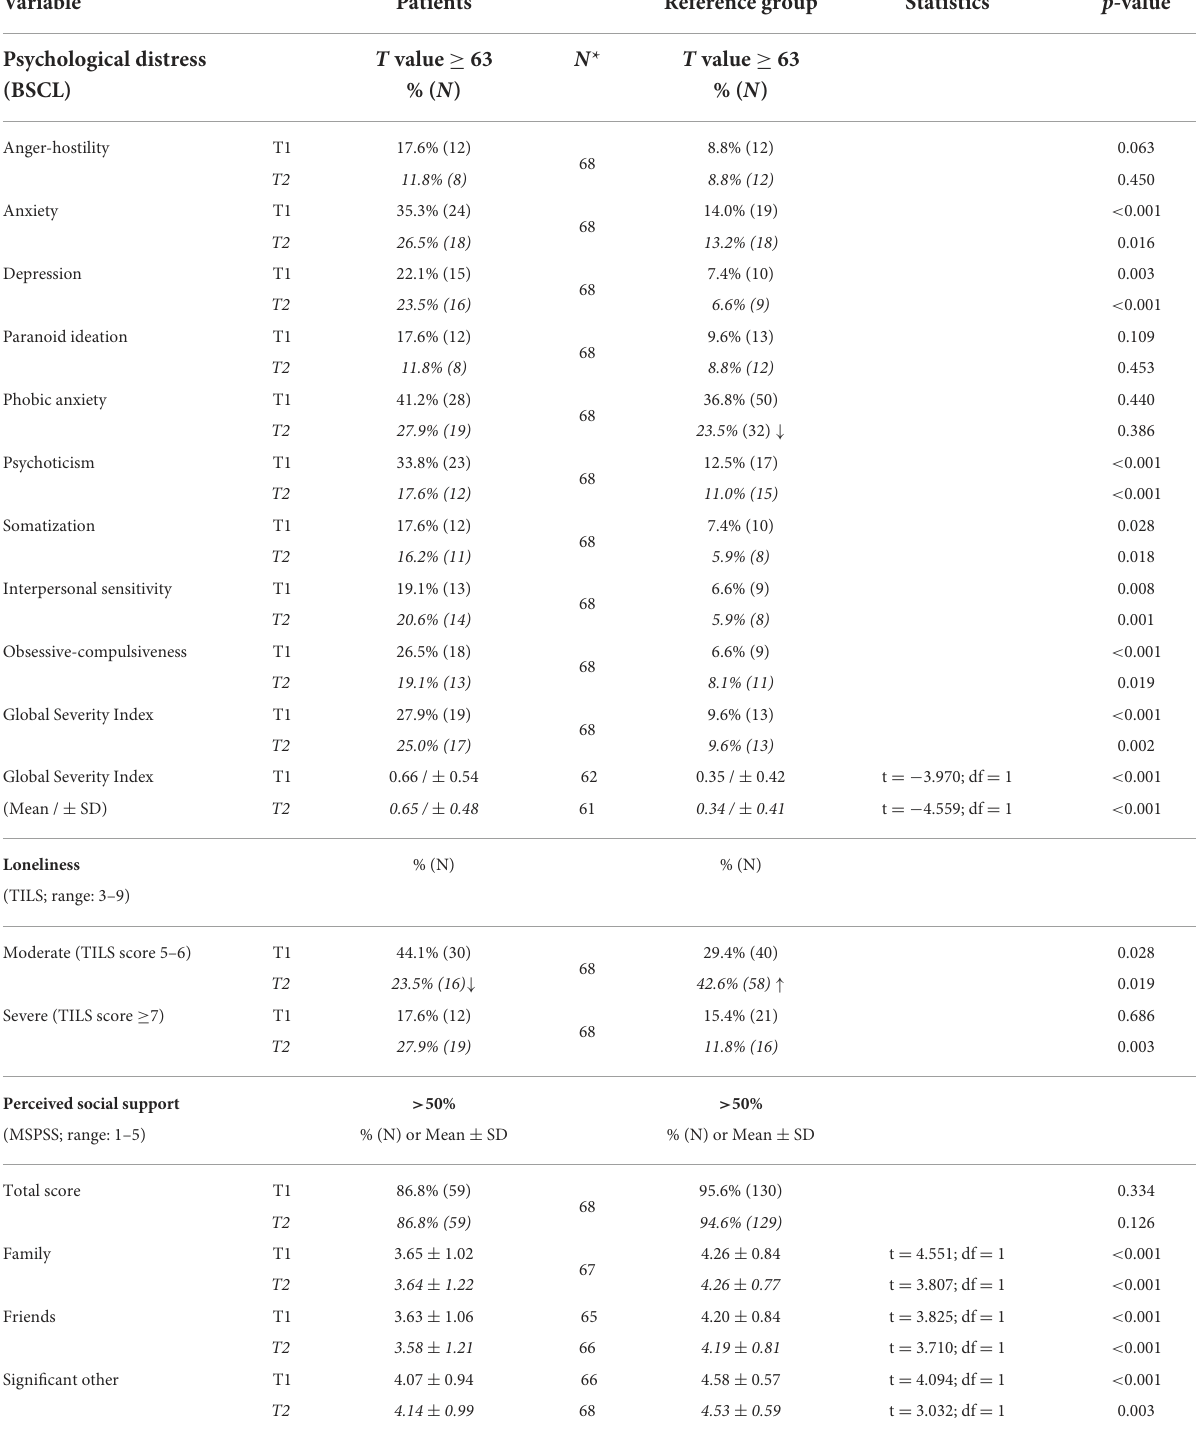
TABLE 2 Psychological distress, loneliness, and perceived social support at baseline (T1) and follow-up (T2). Variable